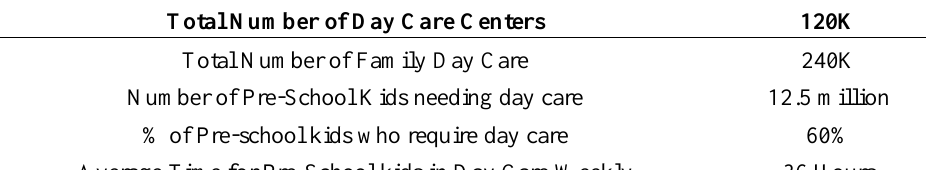
Table 1. Summary statistics of day care centers in the U.S.